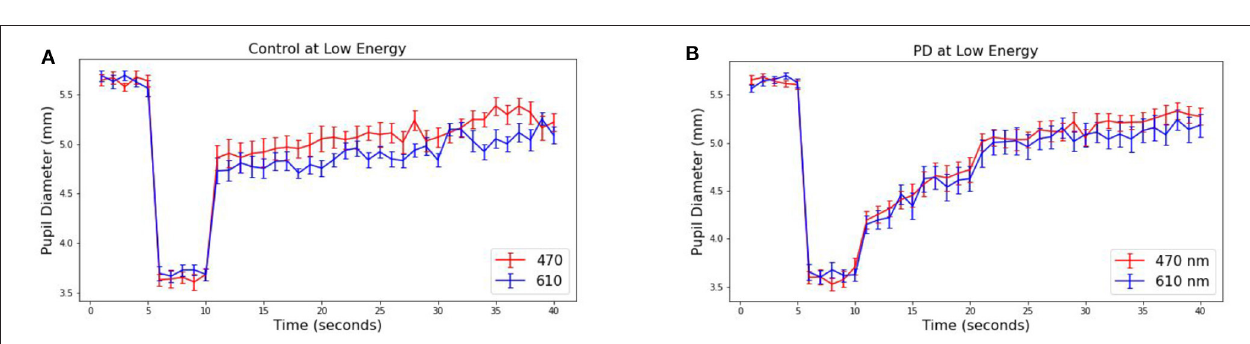
FIGURE 3 | Average pupillary response ( ± SEM) to blue (470) and red (610) light for (A) Control and (B) PD subjects at 30 µ W.